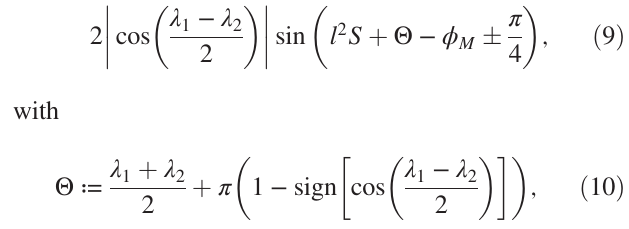
TABLE I. The first three columns distinguish among ten classes of elementary orbits. The map of k ⊥ under g is g ∘ k ⊥ ¼ ð − 1 Þ s ð g Þ ˇ g ⊥ k ⊥ , with ˇ g ⊥ a 2 × 2 orthogonal matrix that represents the point-group component of g in the plane orthogonal to the field; s ð g Þ ¼ 0 if g is purely a spatial transformation, and 1 if g inverts time. j o j ¼ j g ∘ o j indicates that o is mapped to itself under g , modulo a change in orientation. u ð g Þ distinguishes between proper and improper transformations on k ⊥ : ð − 1 Þ u ≔ det ˇ g ⊥ . The fourth and fifth columns describe how unitary matrices ¯ g (that represent the symmetry g ) constrain the propagator. Column six summarizes the constraints on λ if there are none, we indicated this by (cid:2) (cid:2) (cid:2) . u s Symmetry constraints